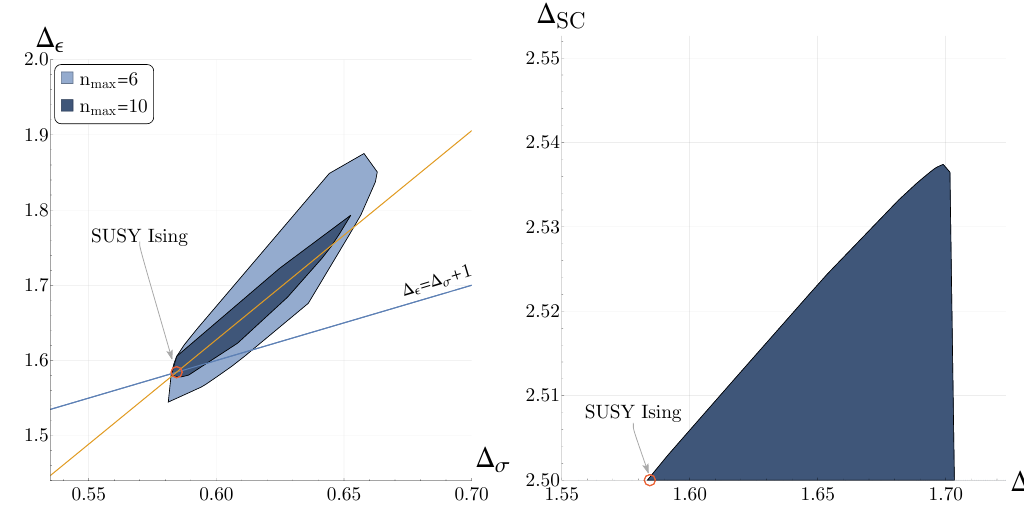
Figure 9 . On the right we show the upper-bound at n max = 10 on the scaling dimension of the lowest spin- 3 / 2 operator as a function of ∆ obtained along an axis of the N = 1 island when (cid:15) imposing ∆ 2 . 5 . The axis was selected such that it interpolates between the location of the σ 0 > N = 1 super-Ising model as determined in previous literature [42–44] and the center of the n max = 10 island. We show this axis projected into (∆ ∆ ) space in orange in the figure on the left. We see σ , (cid:15) that all points along this axis are forced to have a spin- 3 / 2 operator that is close to the unitarity bound, where such operator becomes a supercurrent. The red circle in the plot on the right gives the location of the critical N = 1 super-ising model as determined from the N = 1 superconformal bootstrap